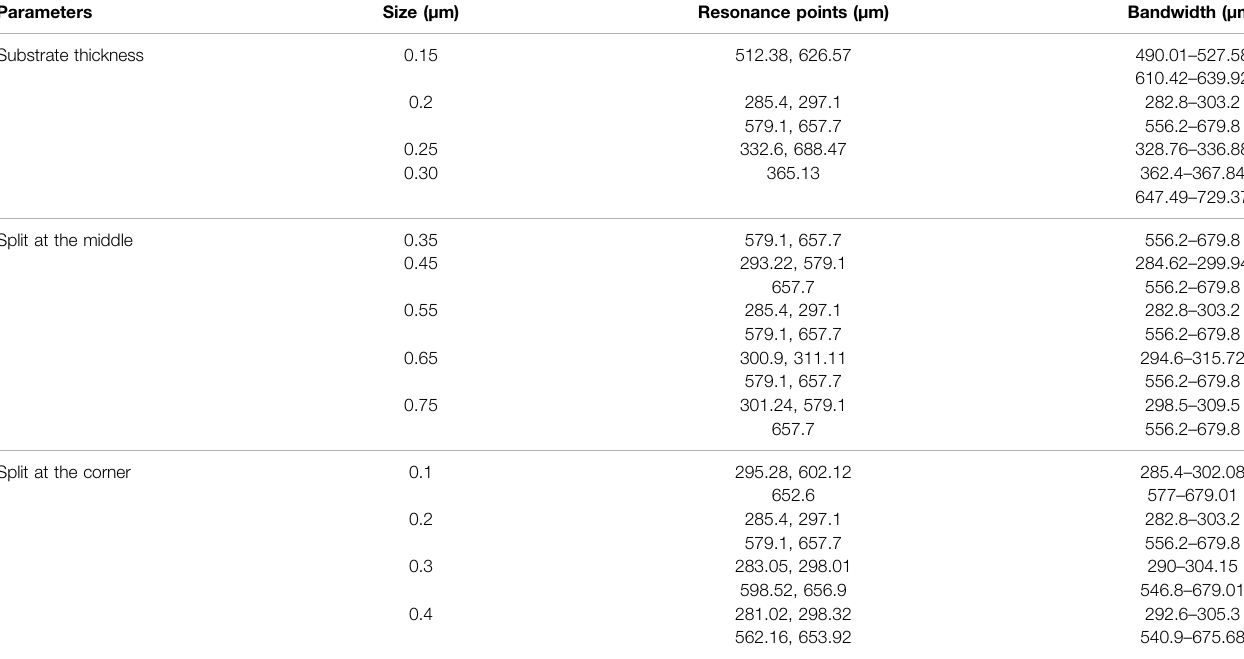
TABLE 1 | Summary of the parametric analysis of the proposed metasurface.